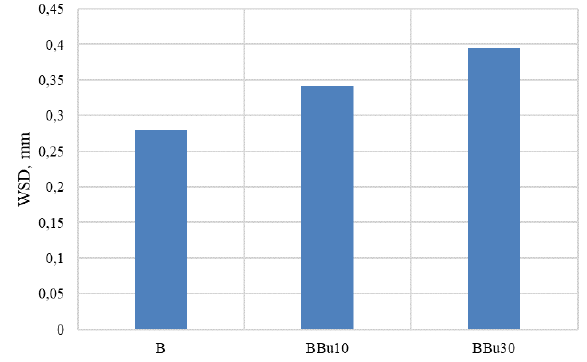
Fig. 1. The dependency of the average wear scar caused by the neat bio- diesel and biodiesel-n-butanol fuel BBu10 and BBu30 blends